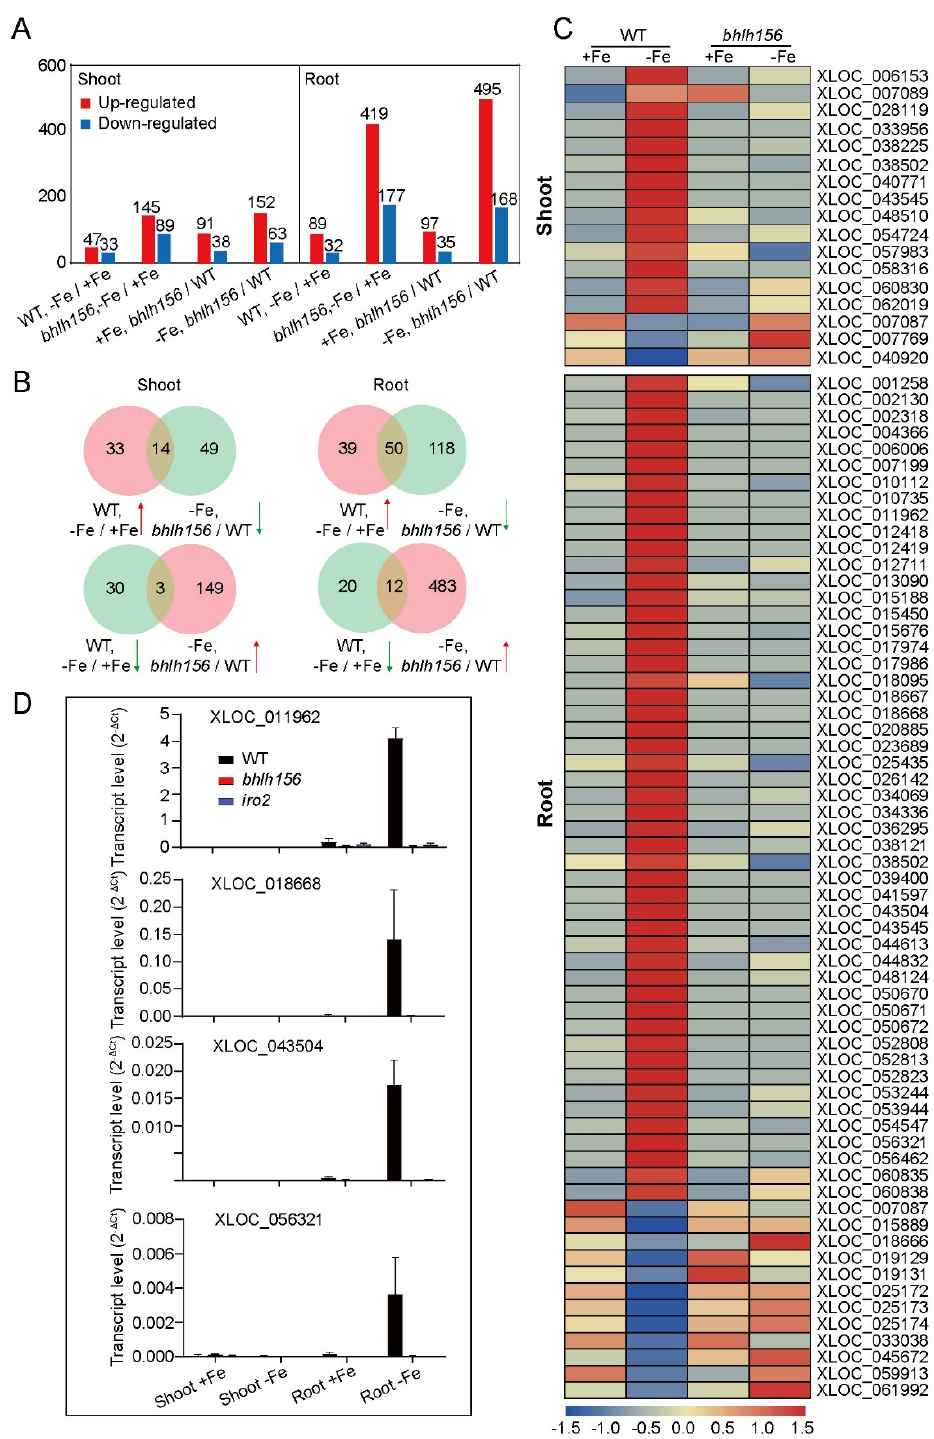
Figure 8. DE-LncRNAs regulated by bHLH156 and IRO2. ( A ) Number of DE-lncRNAs in shoots and roots of bhlh156 mutant under Fe deficiency. The filtering rules is same with that in Figure 2C. ( B ) Venn diagram. ( C ) Heatmap constructed by DE-lncRNAs responded in an antagonistic manner in rice roots under Fe deficiency. The color scale indicates the z -score associated with the DE-lncRNAs. ( D ) Transcript abundance of DE-lncRNAs in shoot and root of WT, bhlh156 and iro2 . Expression was detected by RT-qPCR. Transcript levels were calculated relative to OsActin .